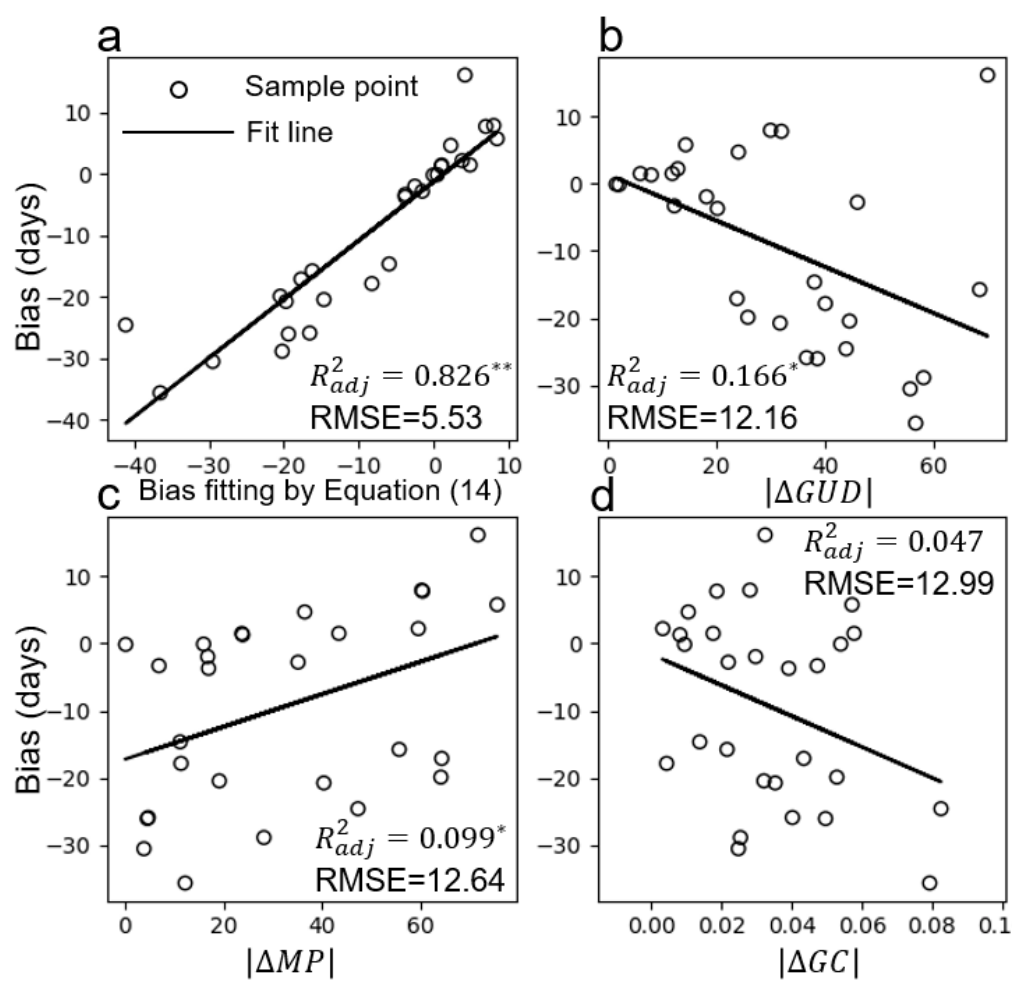
Figure 7. ( a ) Model fitting using the two-endmember model (Equation (14)) and ( b – d ) linearly fitting using only one of the three influential factors. Note that the bias is unrelated to the sign of the factor in three linear factor models, so we used the absolute values of the factors in ( b – d ) to not account for their signs. ** p < 0.01, * p < 0.05.